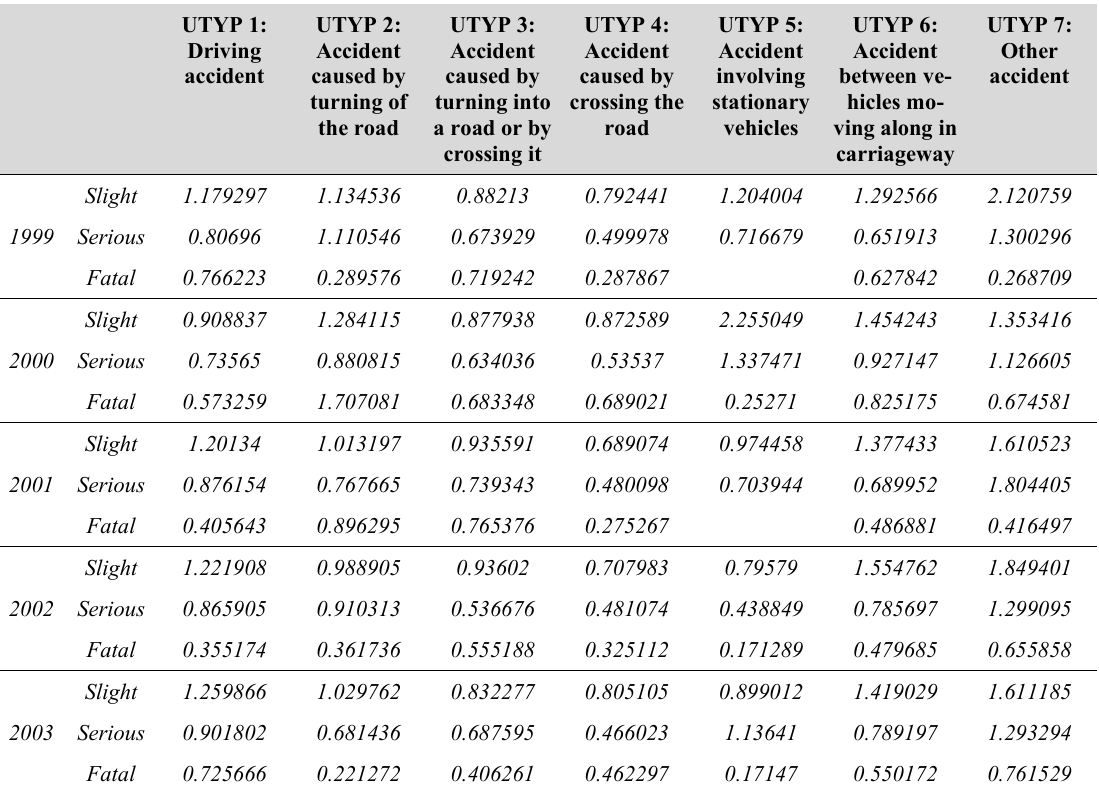
Table A1. Weight factors for crashes recorded in GIDAS by conflict situation (UTYP), year and injury severity to correct sampling bias against German national data. An empty cell means that no such crash was present in the